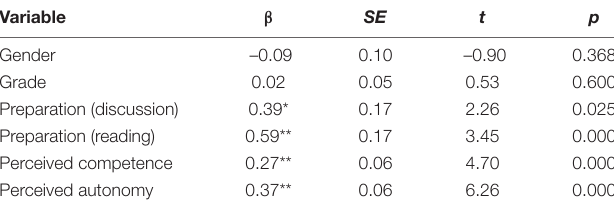
TABLE 3 | Results of the multiple linear regression analysis to investigate predictors of intrinsic